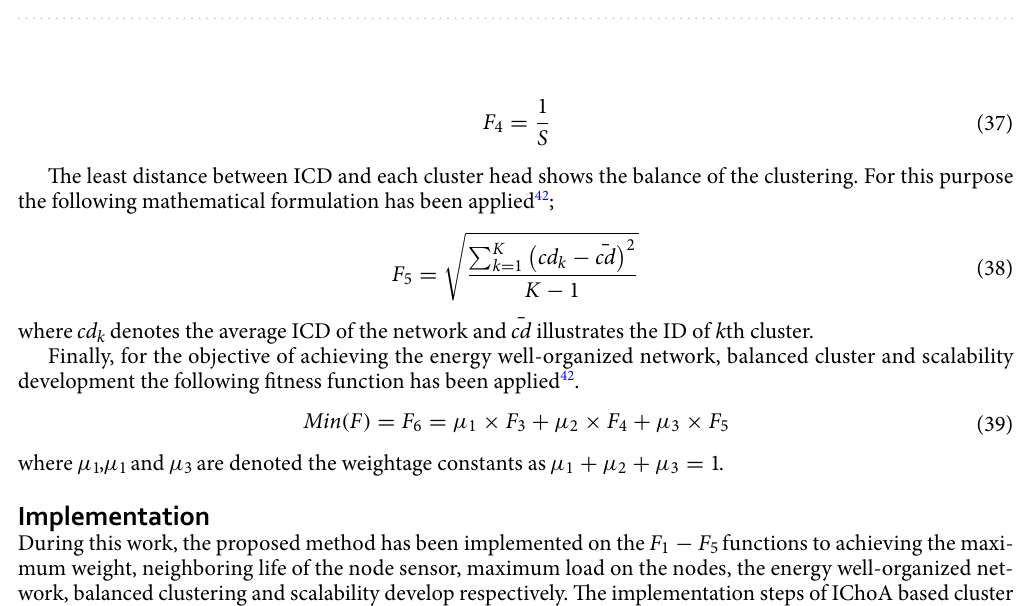
Table 6. Parameter settings for